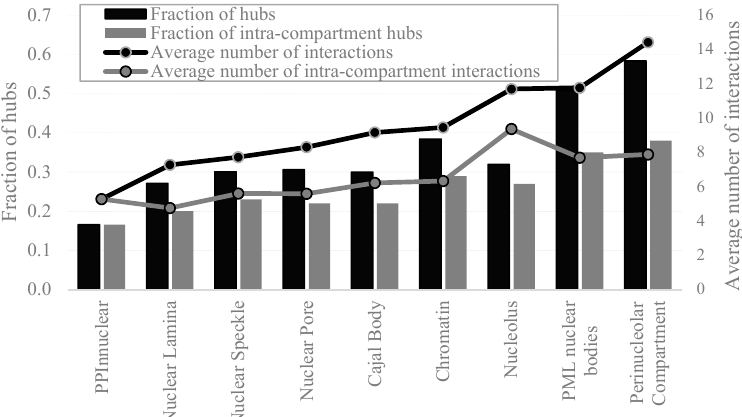
Figure 8. Fraction of hubs (black bars), intra-compartment hubs (gray bars), average number of interactions (black line), and average number of intra-compartments interactions (gray line) for the non-nuclear proteins from the PPI NNUCLEAR dataset and proteins in the considered intra-nuclear compartment from the PPI NUCLEAR ap dataset. Disorder was annotated with the consensus of Espritz and IUPred.